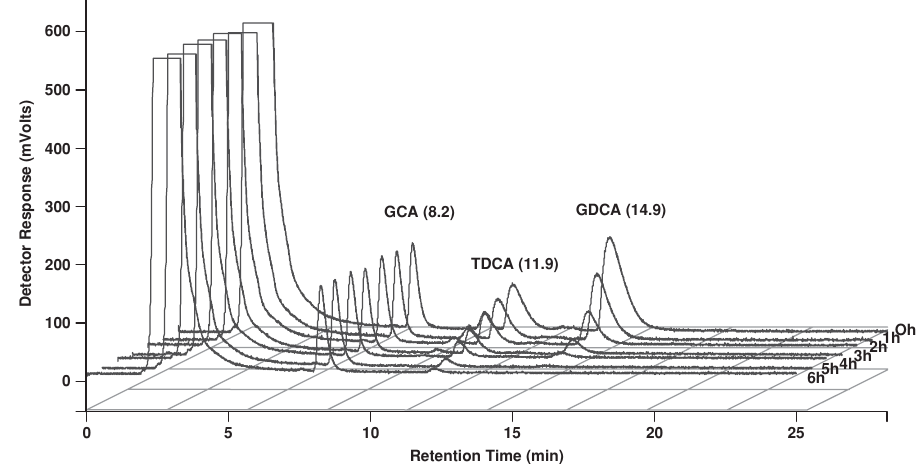
Figure 3 Overlaid HPLC chromatograms of bile acids in reaction media over time (0 h, 1 h, 2 h, 3 h, 4 h, 5 h, and 6 h). Decreasing peak areas of TDCA and GDCA indicate BSH activity of immobilized Lactobacillus plantarum 80 (pCBH1). 34